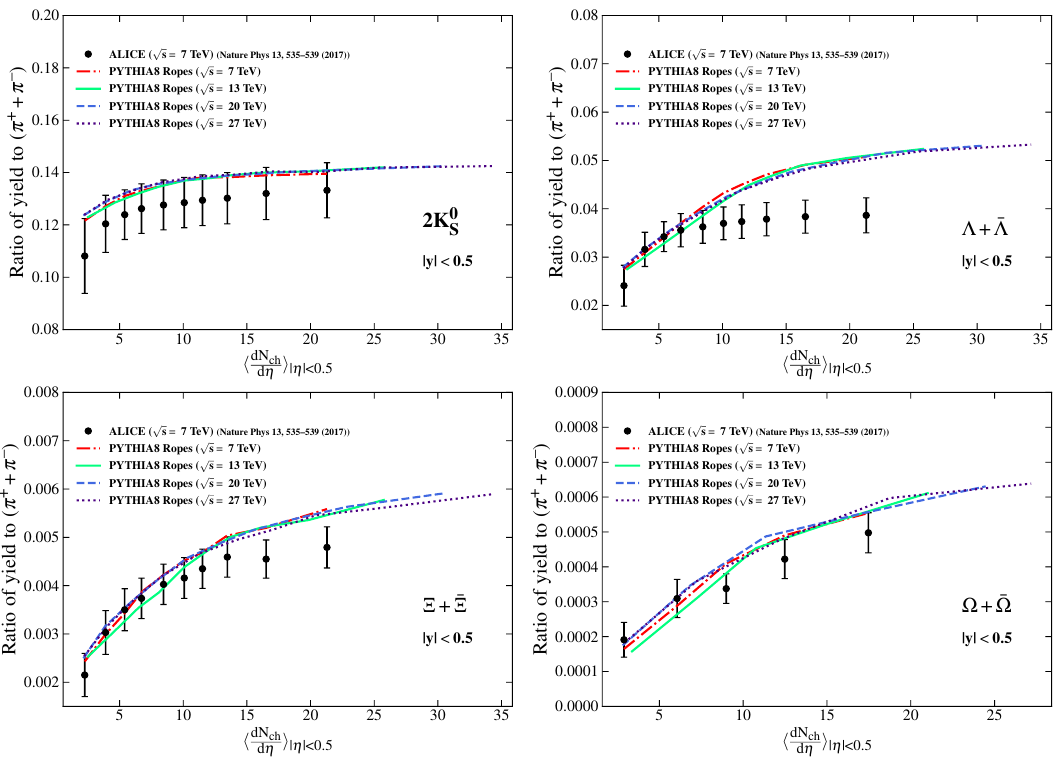
Figure 2. Integrated yield ratios to pions ( π + + π − ) as a function of at √ s = 7 TeV, 13 TeV, 20 TeV, and 27 TeV using PYTHIA8 (Monash tune) [25].